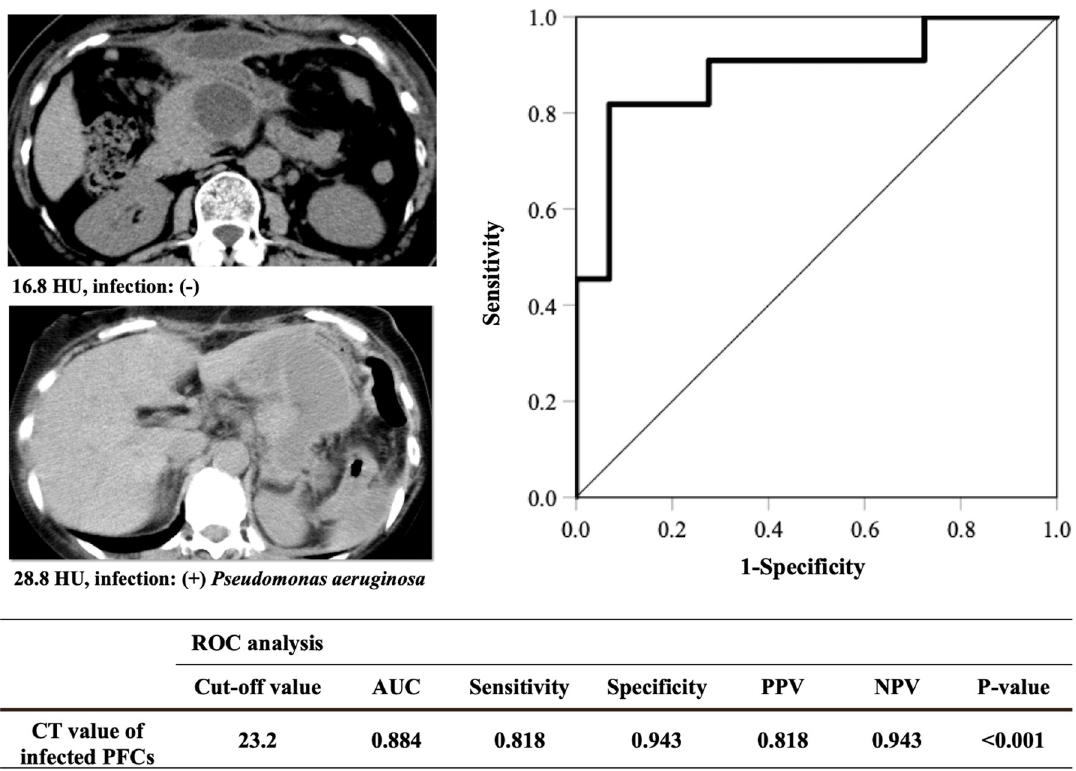
Fig 3. Cut-off value of the CT value of the infected PFCs using ROC curve analysis. AUC: area under curve, CT: computed tomography, HU: Hounsfield units, ROC: receiver operating characteristic, PFCs: peripancreatic fluid collections, PPV: positive predictive value, NPV: negative predictive